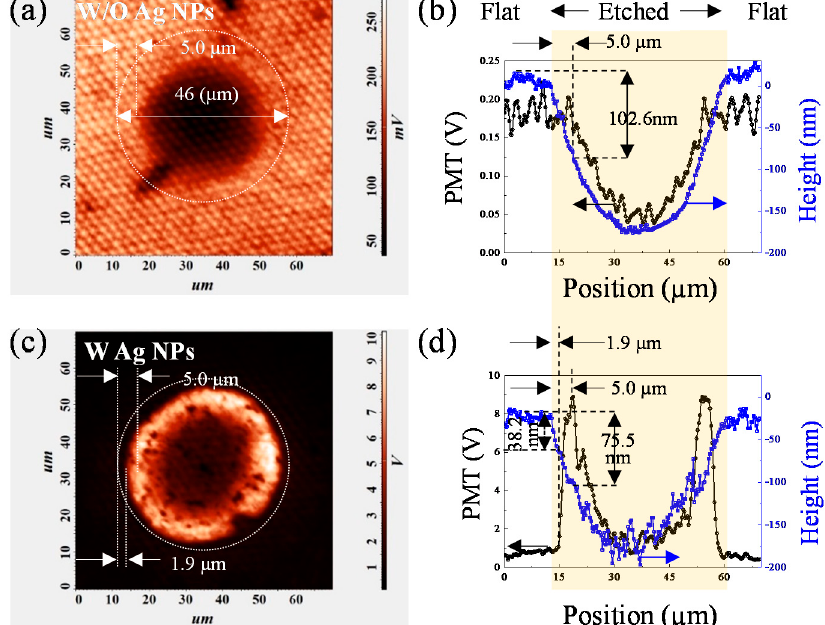
Figure 3. ( a ) Near-field PL mapping and ( b ) cross sectional PL profile and height profile through the center of microcave of sample 1 without Ag NPs; ( c ) Near-field PL mapping and ( d ) PL and height profiles of the microcave of sample 2 with Ag NPs.